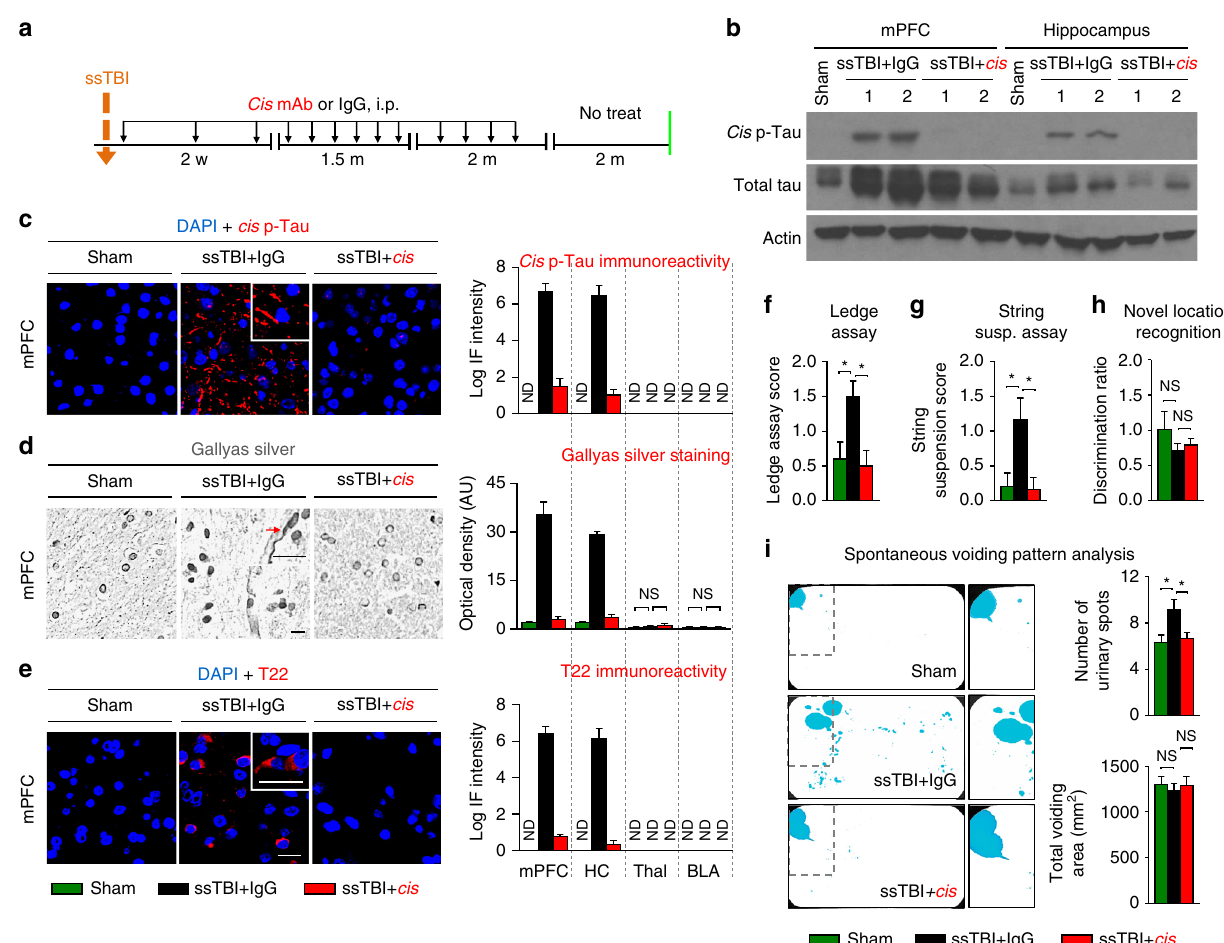
Fig. 5 Eliminating cis P-tau in ssTBI mice with cis mAb prevents a range of pathological and functional outcomes during the chronic phase. Mice were subjected to long-term treatment regimens over 4-months, followed by a 2-month washout a and then underwent functional, biochemical, and pathological examinations. Orange arrows, ssTBI; black arrows, antibody injection; green lines, functional, or pathological assays. Cis mAb treatment of ssTBI mice for 4 months effectively eliminated cis P-tau induction and total tau accumulation b , c , and prevented the development of axonal pathology d and tau oligomerization e both in the cortex and hippocampus, as well as prevented sensorimotor coordination de fi cits, as detected by Ledge assay f and string suspension g and urinary incontinence as assayed by spontaneous urinary pattern i at 6 months after injury, with no de fi cit in novel object location recognition h . Microscope images correspond to the medial prefrontal cortex of sham (left), ssTBI+ IgG (middle), and ssTBI+ cis mAb (right) with quanti fi cation data in different brain regions being present at right panels. Inset images are the high magni fi cation image of selected area denoted by the white. Scale bar, 40 μ m. Axonal bulb also referred to as a retraction ball indicated with red arrow in Gallyas silver staining. mPFC, medial prefrontal cortex; HC, hippocampus; Thal, thalamus; BLA, basolateral amygdala. ND, not detectable; NS, not signi fi cant. Brains from 4 − 5 WT male mice were studied in immunohistochemistry, 5 − 6 mice underwent urinary pattern test and 9 − 10 WT mice underwent other behavioral studies per group. The data were presented as means ± SEM. The p - values were calculated using unpaired two-tailed parametric Student ’ s t -test. * p < 0.05, ** p < 0.01, *** p < 0.001, **** p < spreading of other tau pathology (tau oligomers, early and late tangles) and neurodegenerative pathologies, together with the emergence of more behavioral de fi cits, were observed (Fig. 5 vs. Fig. 4). Notably, intermittent cis mAb treatment for 4 months (Fig. 5a) not only eliminated and blocked spreading of cis P-tau (Fig. 5b, c, Supplementary Fig. 15), axonal pathology (Fig. 5d) and astrogliosis (Supplementary Fig. 6l) into the hippocampus with- out affecting physiologic trans P-tau (Supplementary Fig. 6h), but Fig. 6c, d), Iba1-positive microglia (Supplementary Fig. 6f), TDP- also prevented tau oligomerization (Fig. 5e), tangle-like formation 43 pathology (Supplementary Fig. 6g), A β pathology (Supple- (Supplementary Fig. 6j, k), and APP accumulation (Supplemen- mentary Fig. 7a, b), neuronal loss (Supplementary Fig. 7c) or tary Fig. 6i). We did not detect reactive microgliosis (Supple- demyelination (Supplementary Fig. 7d, e) in the two TBI groups mentary Fig. 6m), TDP-43 pathology (Supplementary Fig. 6n), compared with sham mice at 2 weeks after severe injury. A β pathology (Supplementary Fig. 7f, g), neuronal loss (Supple- mentary Fig. 7h) or demyelination (Supplementary Fig. 7i, j) in all three groups at 6 months after ssTBI. Functionally, ssTBI did not Cis mAb improves chronic phase outcomes after ssTBI . In lead to de fi cits in the novel location recognition (Fig. 5h) or contrast to 2 weeks after ssTBI, at 6 months the development and